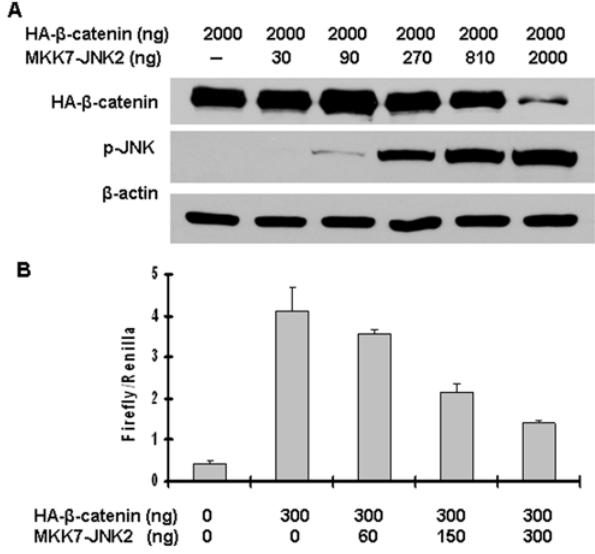
Figure 2. Active JNK2 downregulated b -catenin expression and inhibited its transcriptional activity in a dose-dependent manner. (A) Activated JNK2 reduced b -catenin protein level in a dose-dependent manner. HEK293T cells were co-transfected